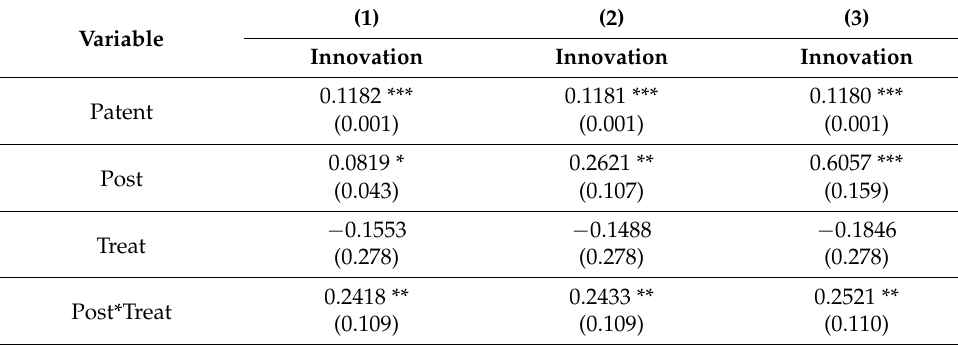
Table A1. The robustness test of the basic